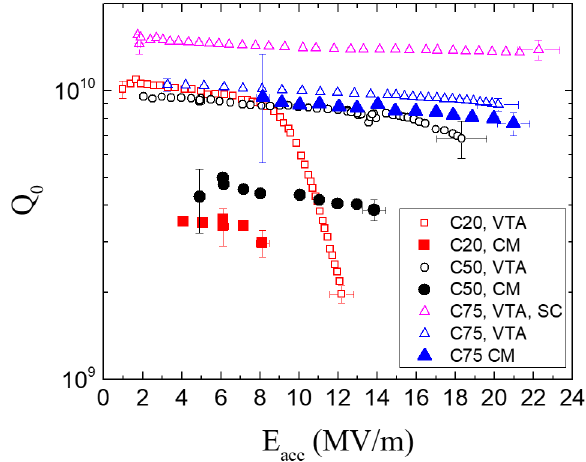
Þ measured at 2.07 K for typical C20, C50, and FIG. 1. Q 0 ð E acc